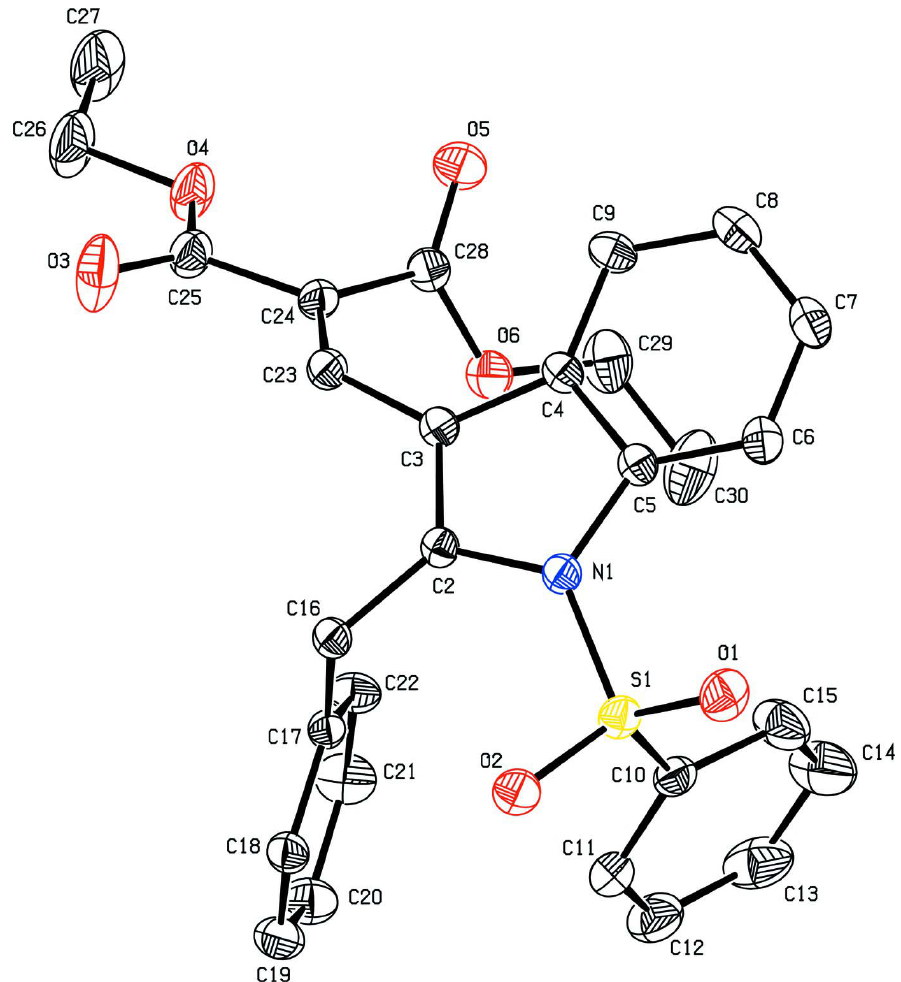
The molecular structure of the title compound. Displacement ellipsoids are drawn at the 20% probability level. H atoms have been omitted for